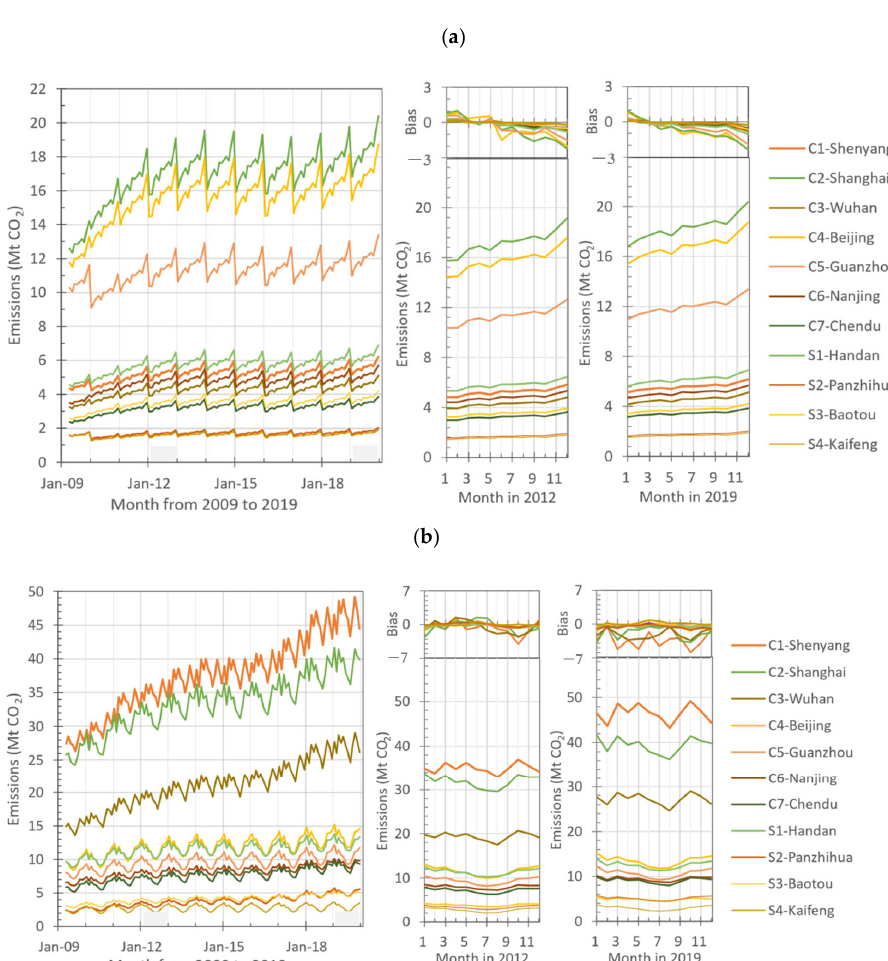
Figure 8. Time series of averaged inventory emissions in the ROIs from 2009 to 2019 (left column)